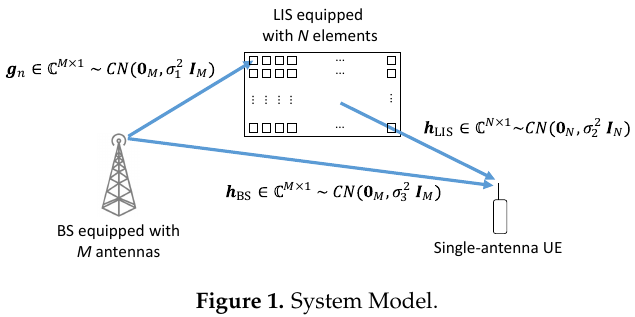
Figure 1. System